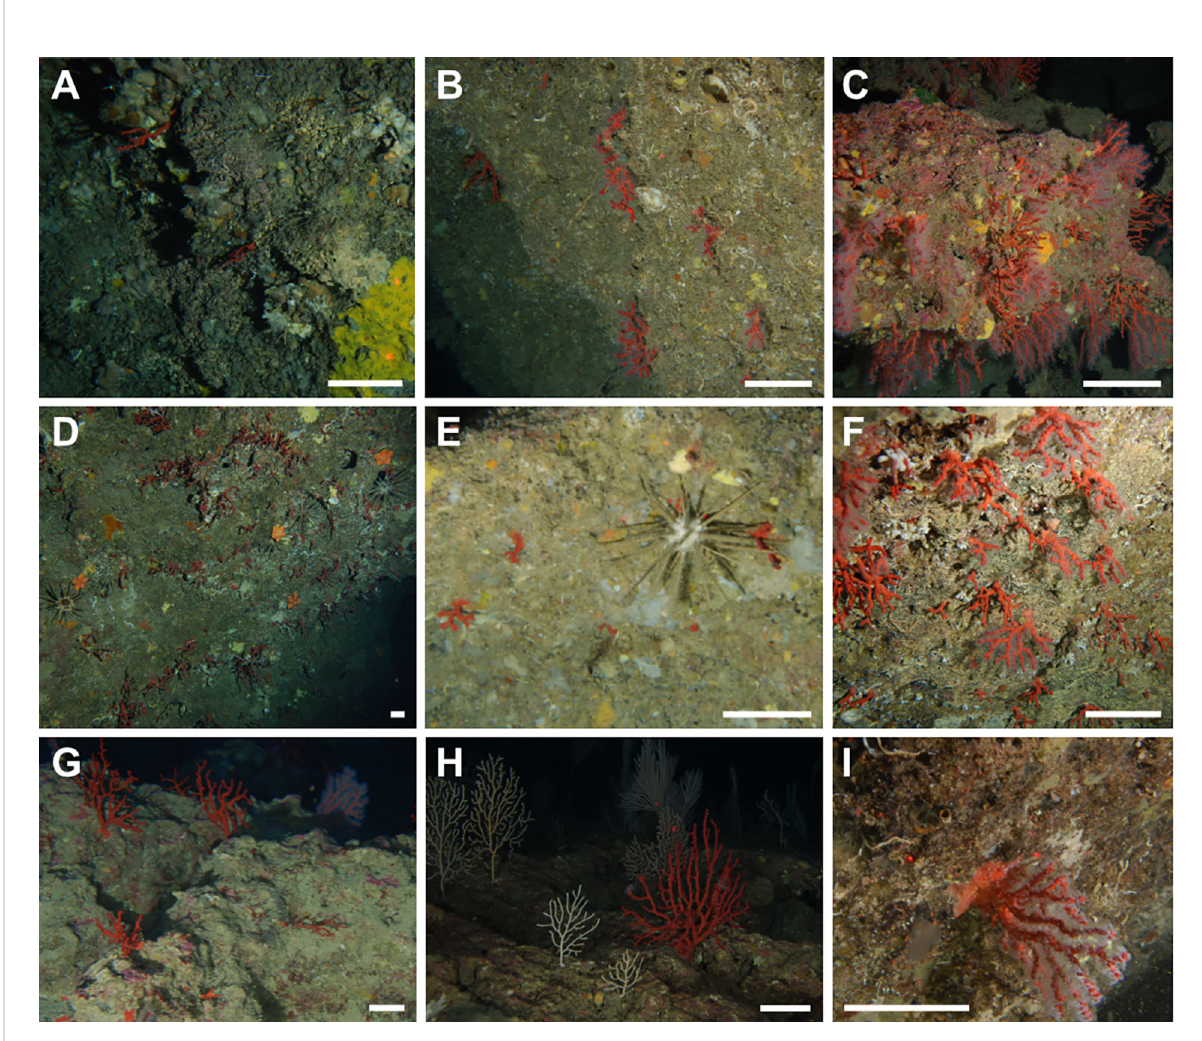
FIGURE 3 Corallium rubrum aggregations. (A) Scattered colonies on a vertical cliff in Palmi (Tyrrhenian Calabria, 85 m); (B) vertical rocky wall hosting aggregated colonies of C rubrum in Giglio Island (Tuscan Archipelago, 100 m); (C) very dense aggregation of red coral on a sloping CCA- covered rock in Punta delle Oche (SW Sardinia, 85 m); (D) Peltaster placenta (Müller & Troschel, 1842) and Stylocidaris af fi nis (Philippi, 1845) feeding on a dense aggregation of small living and dead colonies of C rubrum (Porto Corallo, SE Sardinia, 95 m); (E) very small colonies predated by S. af fi nis (Montecristo Island, Tuscan Archipelago, 84 m); (F) medium-size red coral colonies coexist with the white scleractinian Thalamophyllia gasti (Döderlein, 1913) on the vertical cliffs of Boi Cape (South Sardinia, 108 m); (G) large colonies fl ourish on the sub-horizontal CCA-covered rocks in the Ragusa Bank (Sicily Channel, 85 m); (H) a large colony surrounded by Eunicella cavolini (Koch, 1887) and Callogorgia verticillata (Pallas, 1766) (Capo Teulada, SW Sardinia, 124 m); (I) a single large colony of the precious coral hanging from a vertical rocky cliff on the Palinuro Seamount (121 m). Scale bar: 10